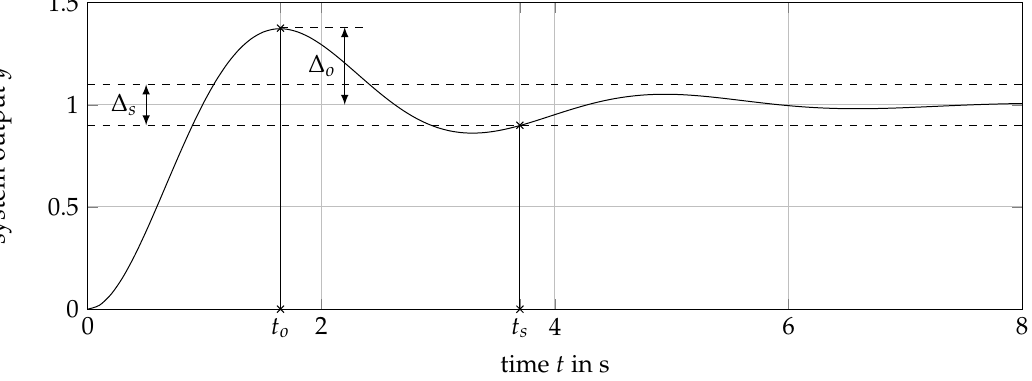
Figure 21. Schematic of a step response and its characteristics.